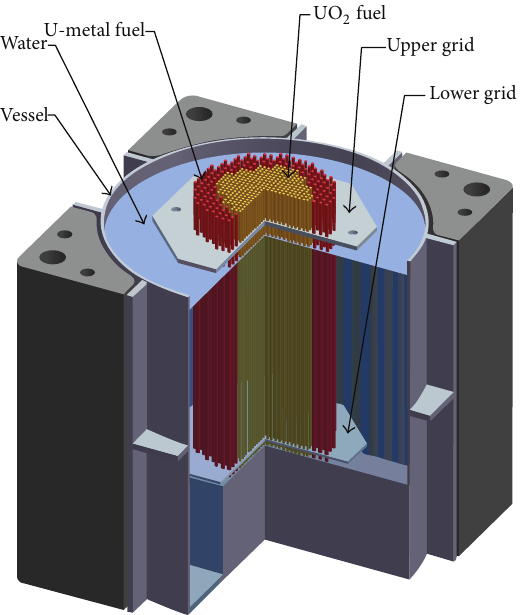
Figure 2: CROCUS reactor supporting structure and core